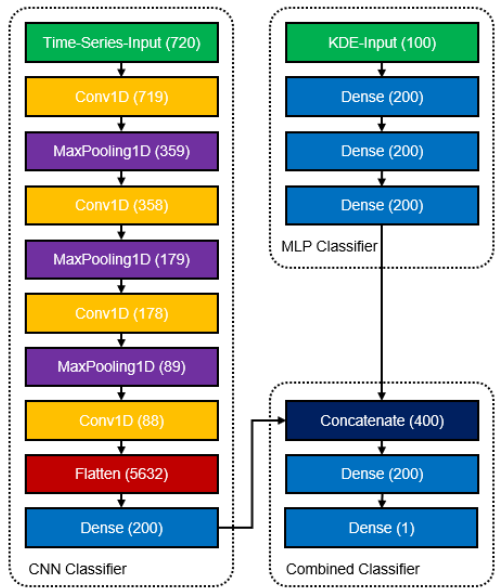
Figure 6. Structure of the Combined Classifier supplemented by the output shapes of the layers based on the time series data/kernel density estimation with the monthly input time